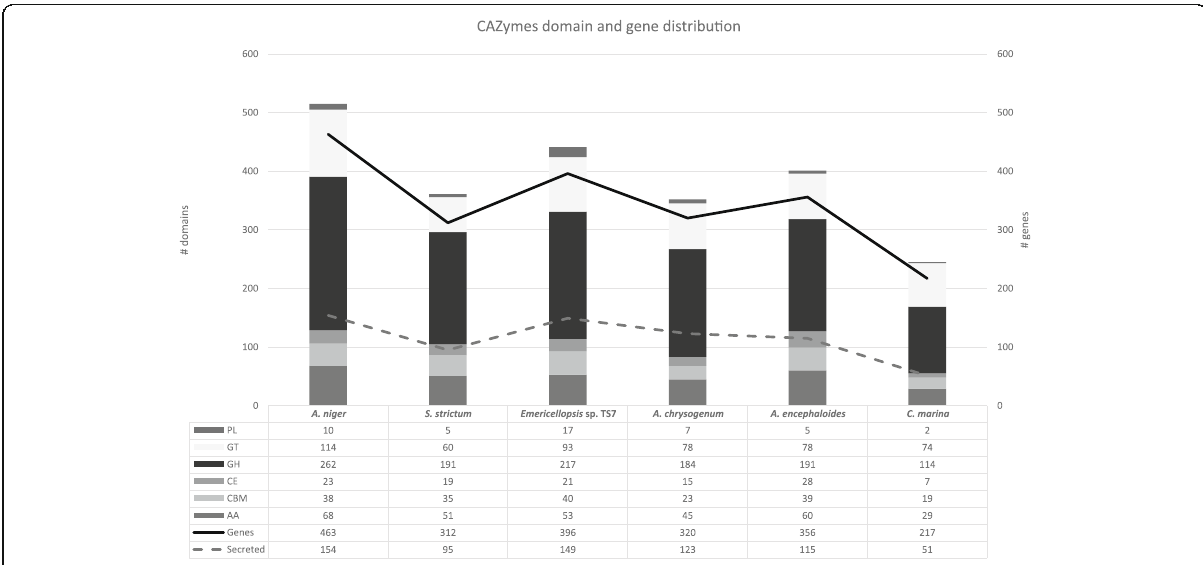
Fig. 3 Overview of the distribution of CAZymes in Emericellopsis sp. TS7 Amylocarpus encephaloides and Calycina marina and three other fungi. The lines indicate the number of genes and number of genes with putative secretion signal and uses the secondary